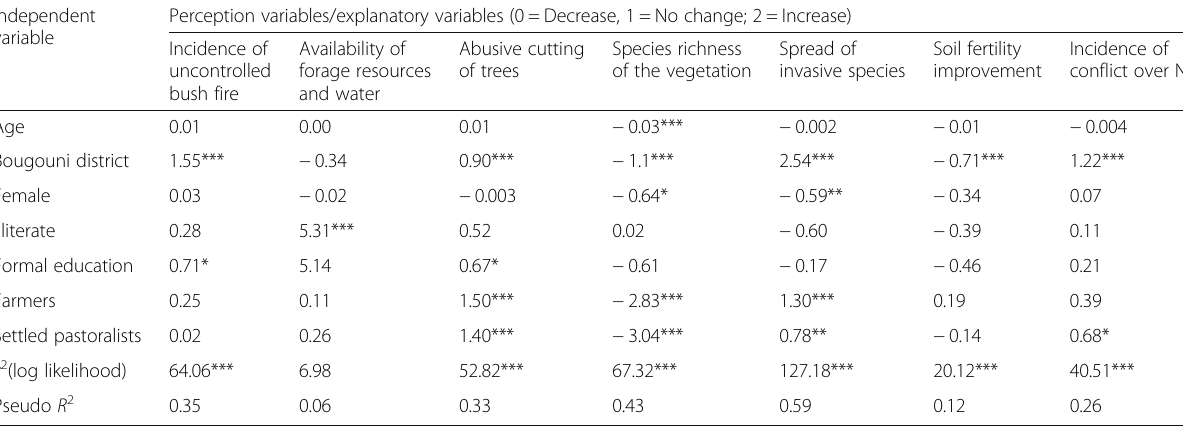
Table 5 Results of ‘ ordered probit ’ regression model of the respondent ’ s perception of impact of transhumant practices on NRM Independent